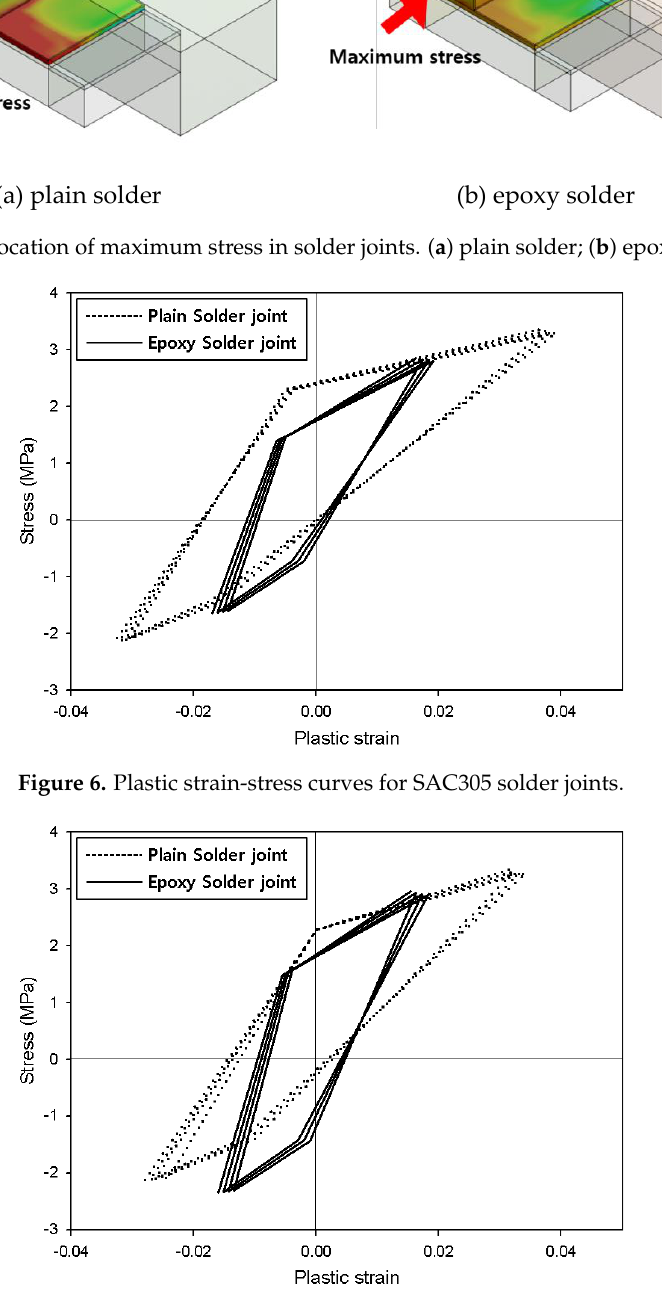
Figure 7. Plastic strain-stress curves for Sn58Bi solder